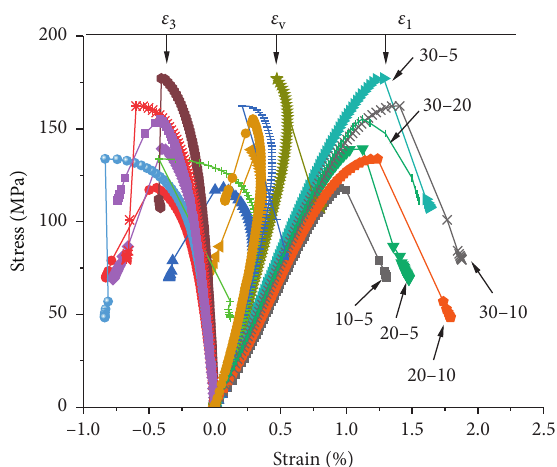
Figure 4: Stress-strain curves under variable pore water and confining pressures